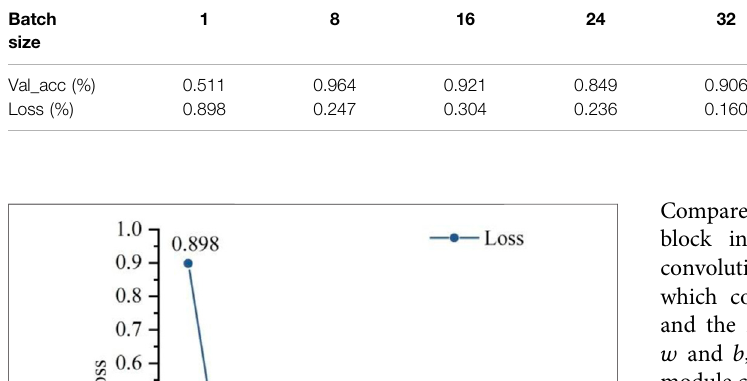
TABLE 3 | Batch Size optimization process with different loss function values. Batch size